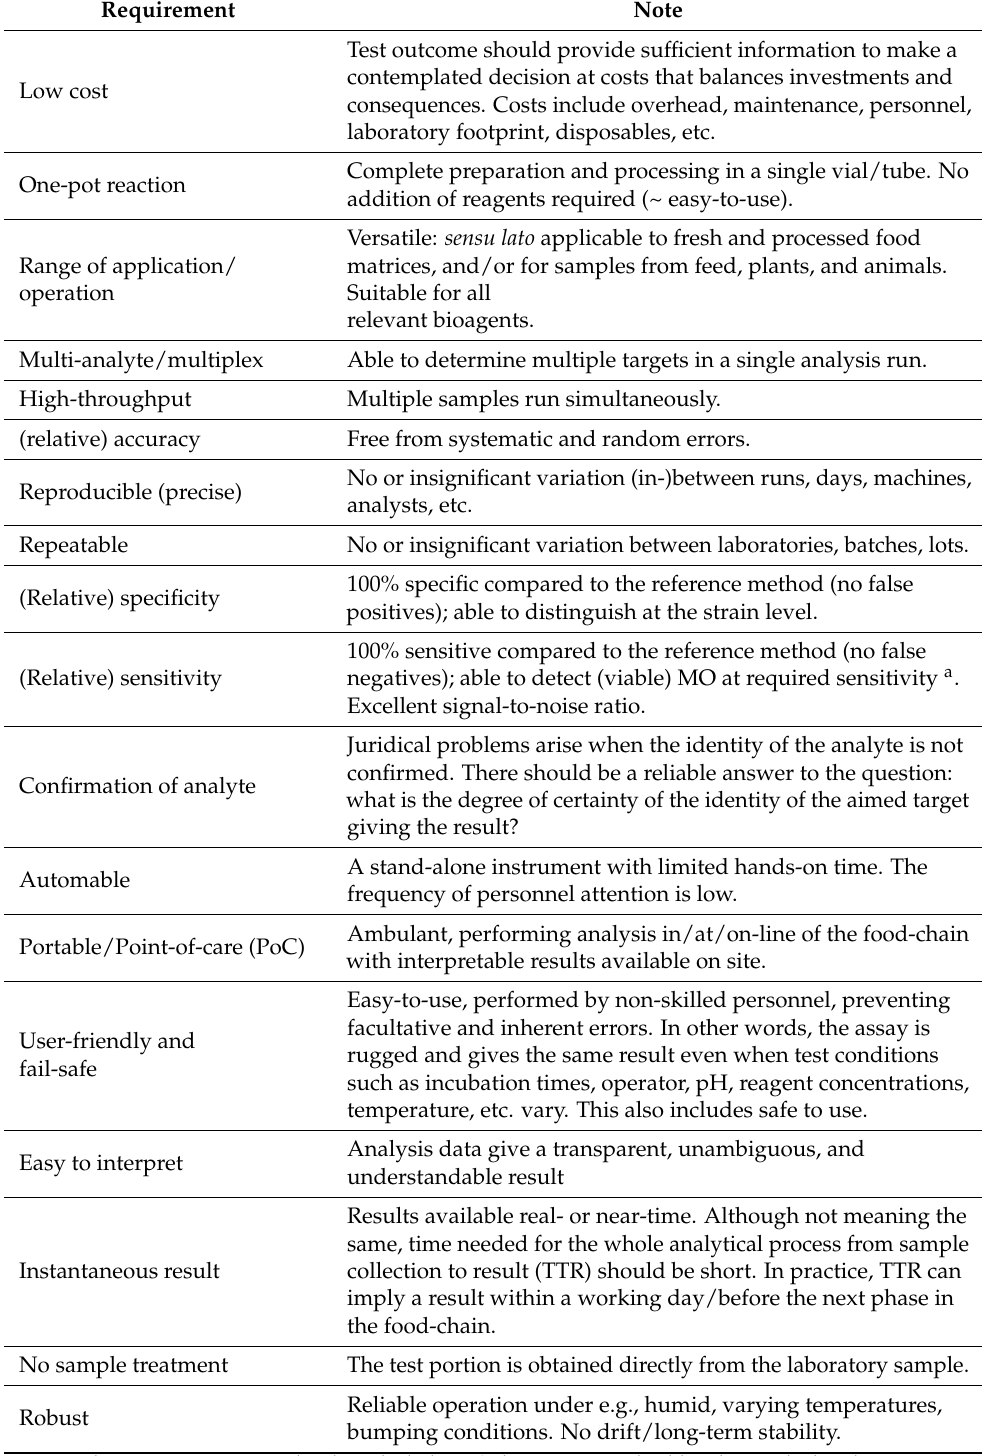
Table 4. Typical end-user requirements for assays that determine MOs in the food-chain. The order of listed requirements is